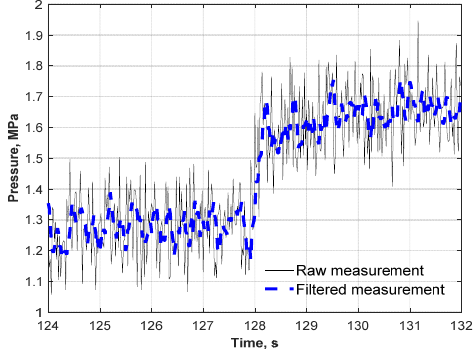
Figure 7. Filtering pressure signal in the window of five specimens for 100 ms.